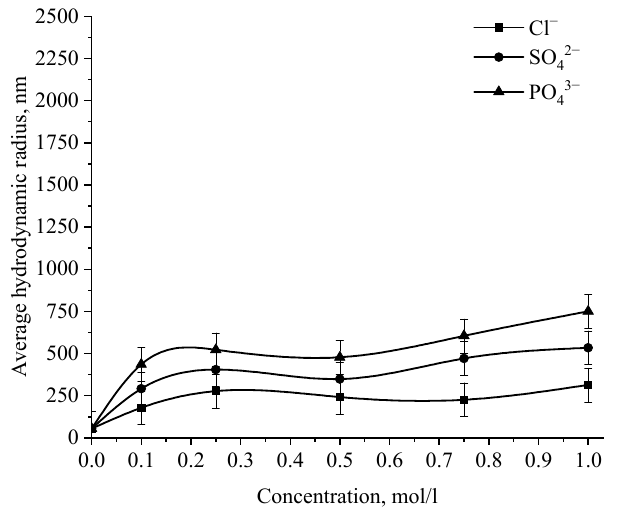
Figure 14. Dependence of the average hydrodynamic radius of Se NPs in negative sol on the concentration of various anions.